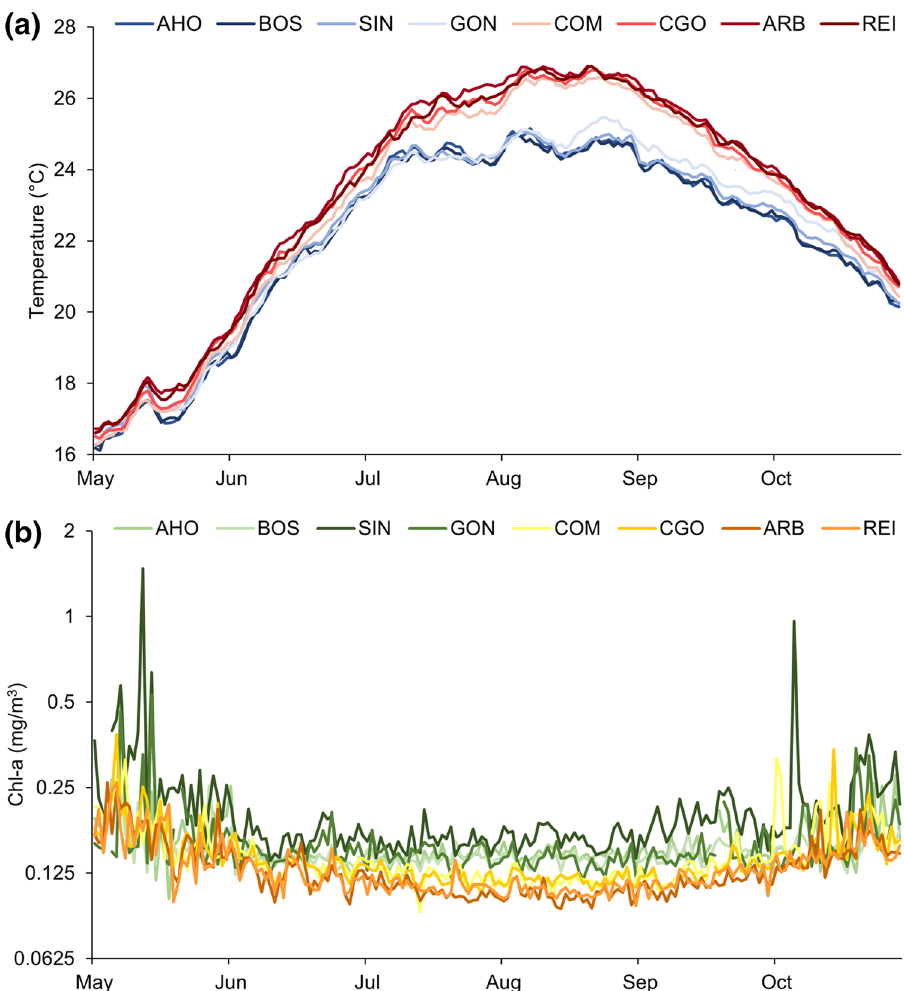
Figure 7. Mean variation from 1st May to 31st October in (a) temperature (°C), in blue the western locations and in red the eastern, and (b) Chl- a (mg/m 3 ), in green the western locations and in yellow the eastern). The y axis of the latter plot is log 2 scale.